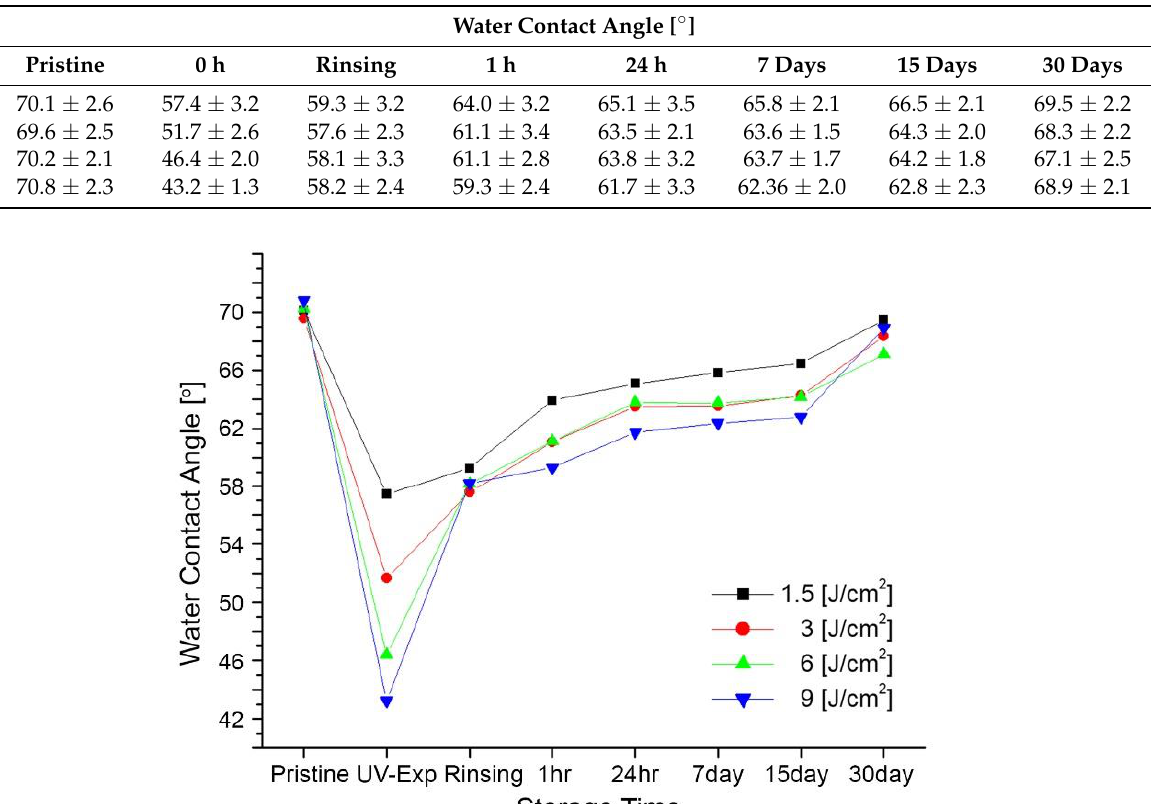
Figure 6. Water drops and contact angles on the surface of IPA-rinsed PMMA after UV irradiation: ( a ) UV dose of 1.5 J/cm 2 : 59.96°, ( b ) UV dose of 3 J/cm 2 : 57.14°, ( c ) UV dose of 6 J/cm 2 : 57.82°, ( d ) UV dose of 9 J/cm 2 : 58.77°. Table 2. Water contact angle of PMMA for rinsing samples after UV exposure.